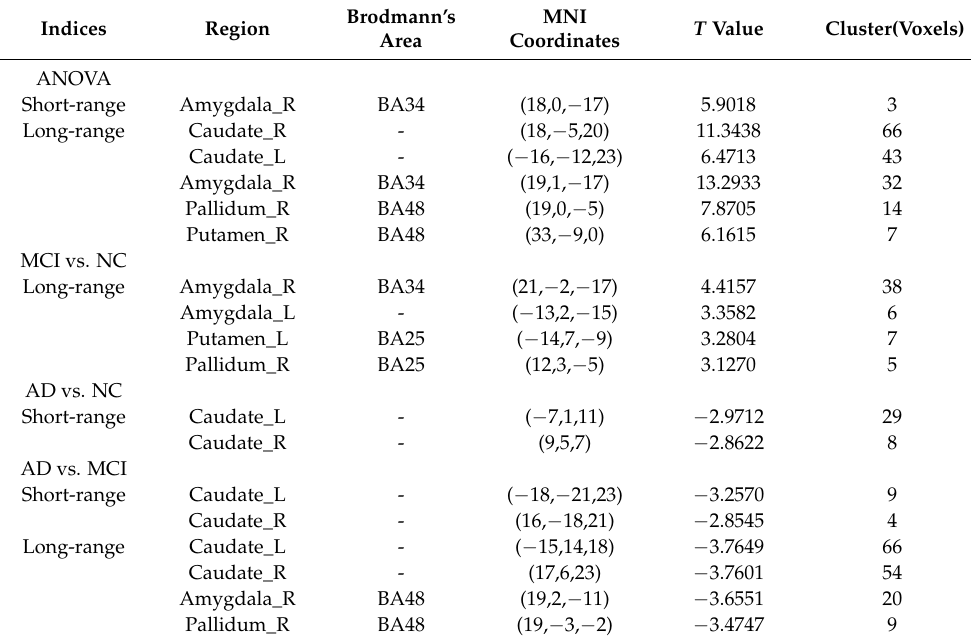
Table 2. FCDs among-group comparison in the AD, MCI, and NC groups (voxel-level p < 0.01 and cluster-level p < 0.05,